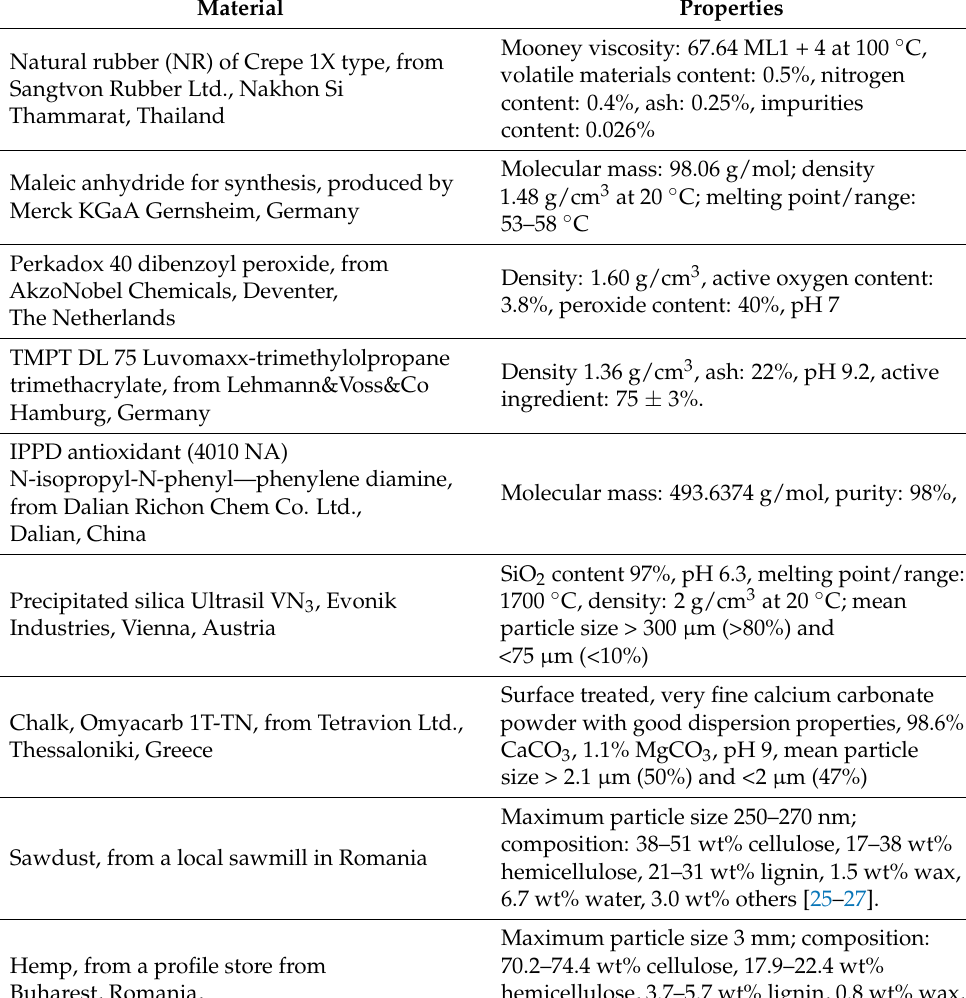
Table 1. Physical and chemical characteristics of raw